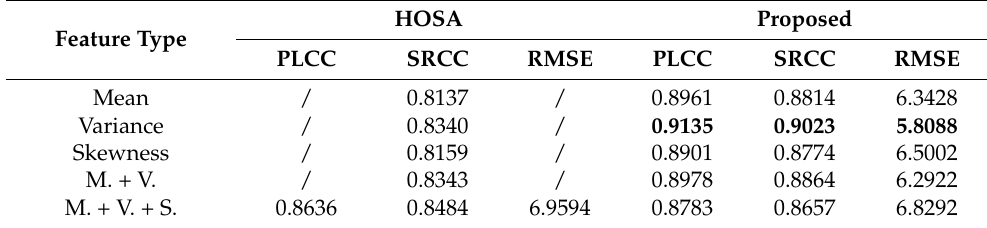
Table 11. Comparison of prediction performances with HOSA on